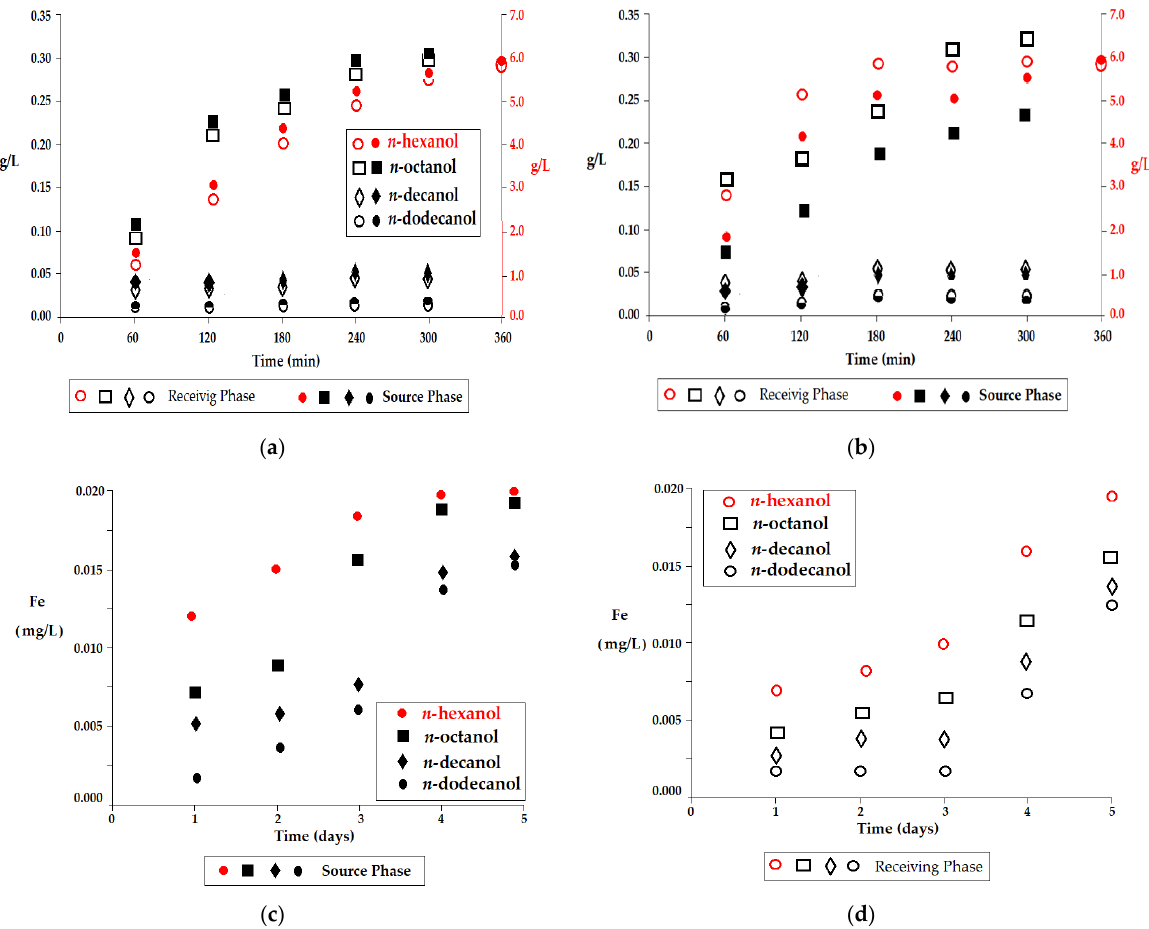
Figure 3. Material losses from the dispersion bulk liquid membrane: ( a ) n -alkyl alcohol in the aqueous phase (pH = 7 in the source phase, and pH = 1 in the receiving phase); ( b ) n -alkyl alcohol in aqueous phase (pH = 1 in the source phase, and pH = 11 in the receiving phase); ( c ) iron in the source phase; ( d ) iron in the receiving phase.